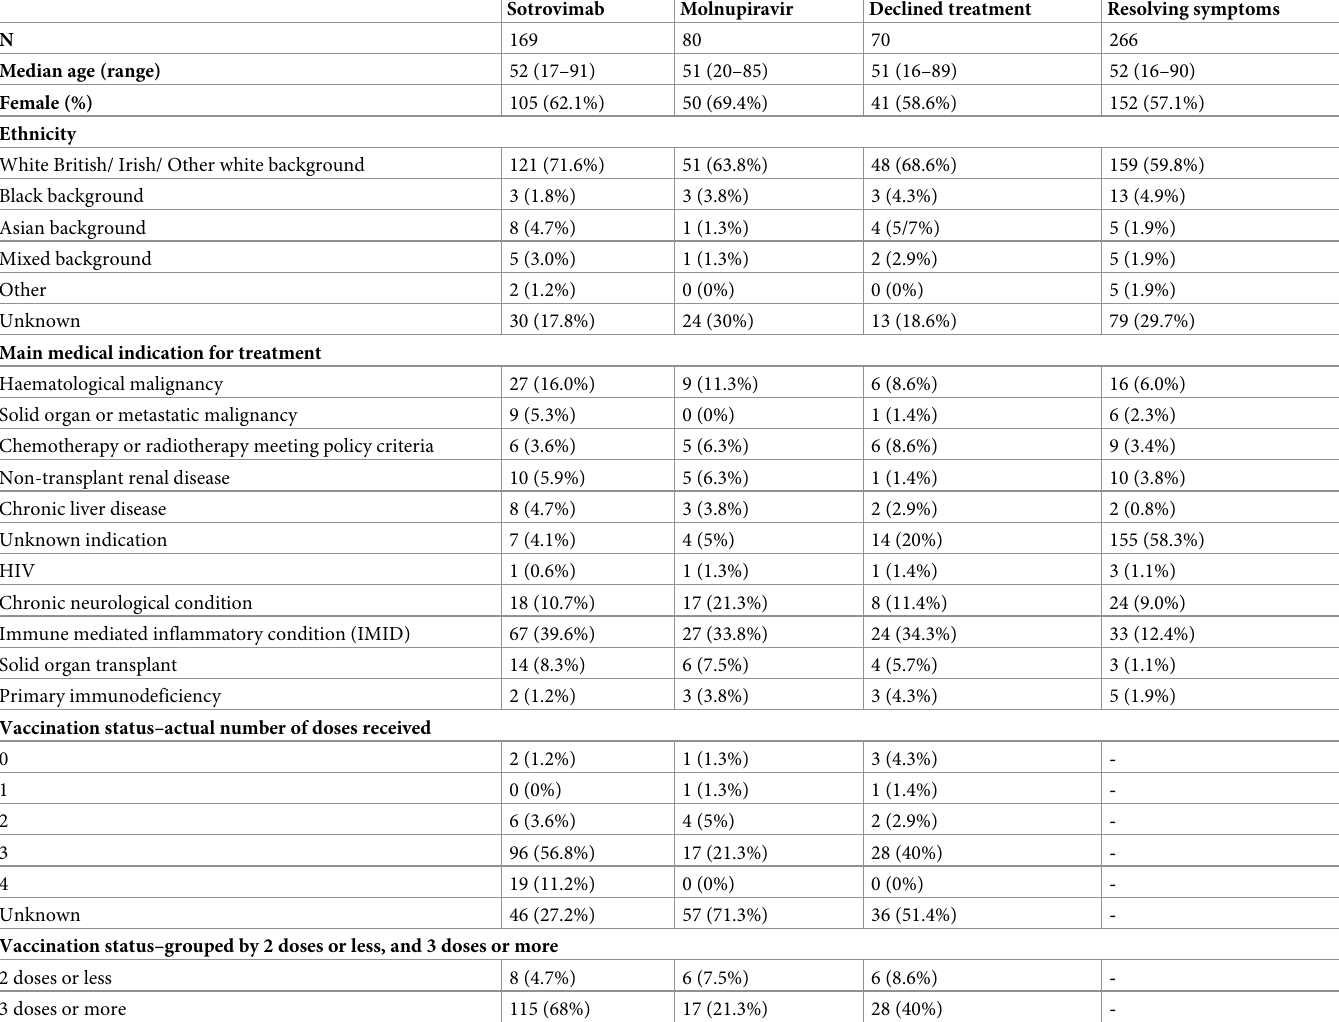
Table 2. Demographic details, indications for treatment, and vaccination status of patients screened within 5 days of symptoms